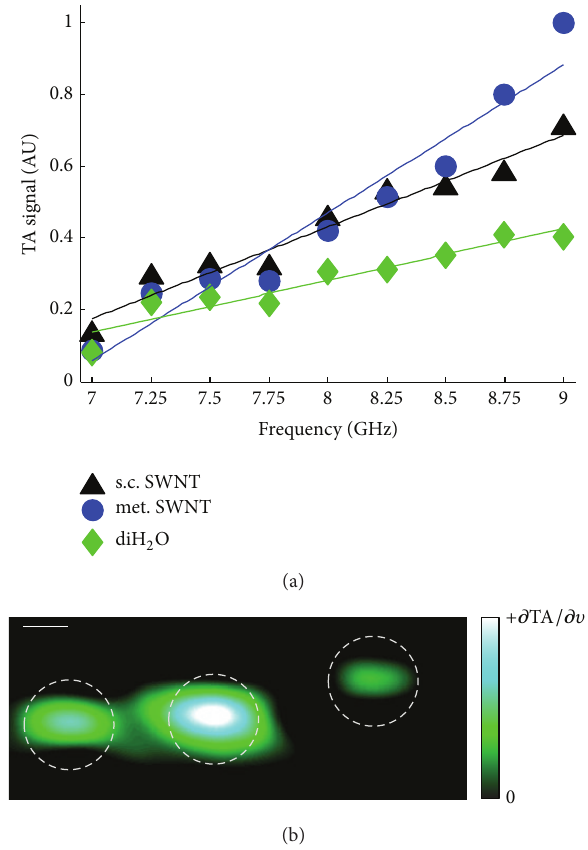
Figure 4: (a) Average TA signal from semiconducting SWNTs, metallic SWNTs, and deionized water. The semiconducting and metallic SWNT solutions had respective slopes of 1.75 AU/GHz ( 𝑅 2 = 0.95 ) and 2.8 AU/GHz ( 𝑅 2 = 0.93 ), with respect to the water = 1.0 AU/GHz, 𝑅 2 = 0.91 ); 𝑝 < 0.01 for baseline (i.e., 𝑚 water diH 2 O all three samples. (b) Cross-sectional image of the slope of the TA signal,asafunctionofmicrowaveexcitationfrequency, ascalculated from the pixel-wise least-squares best-fit line. Tube cross-sections are outlined by dashed gray circles.